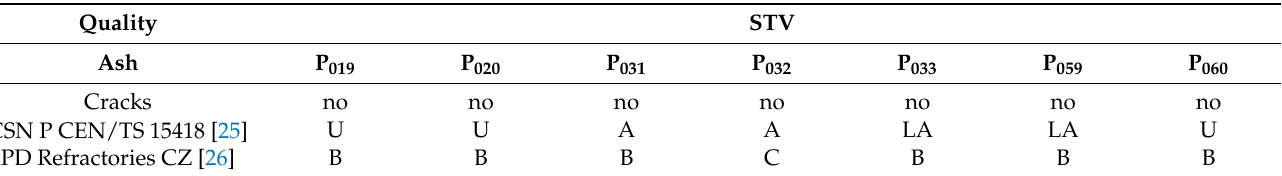
Table 7. Evaluation of STV refractory material corrosion at 1200 ◦